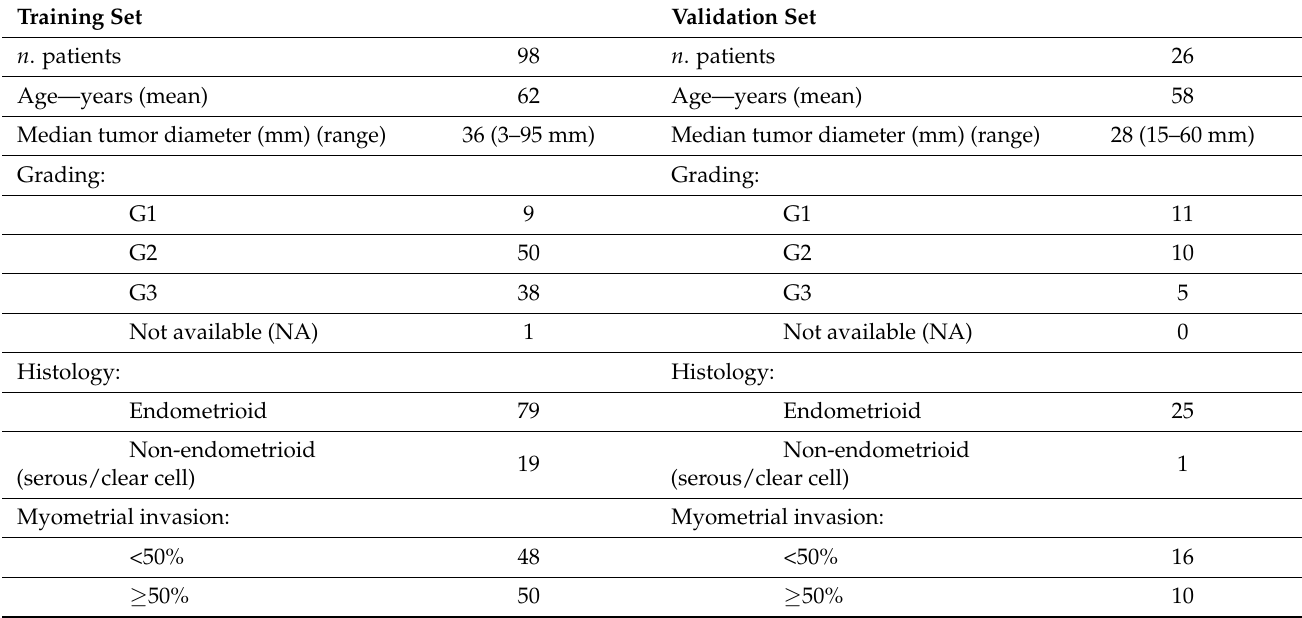
Table 2. Clinical and histological characteristics for patients with endometrial cancer, included in the training set and validation